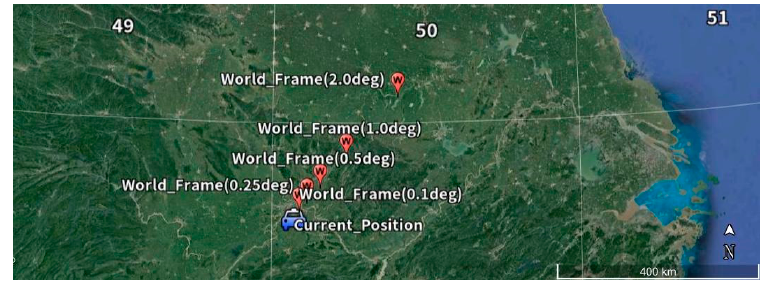
Figure 4. The new position of the world frame with different geodetic displacement.